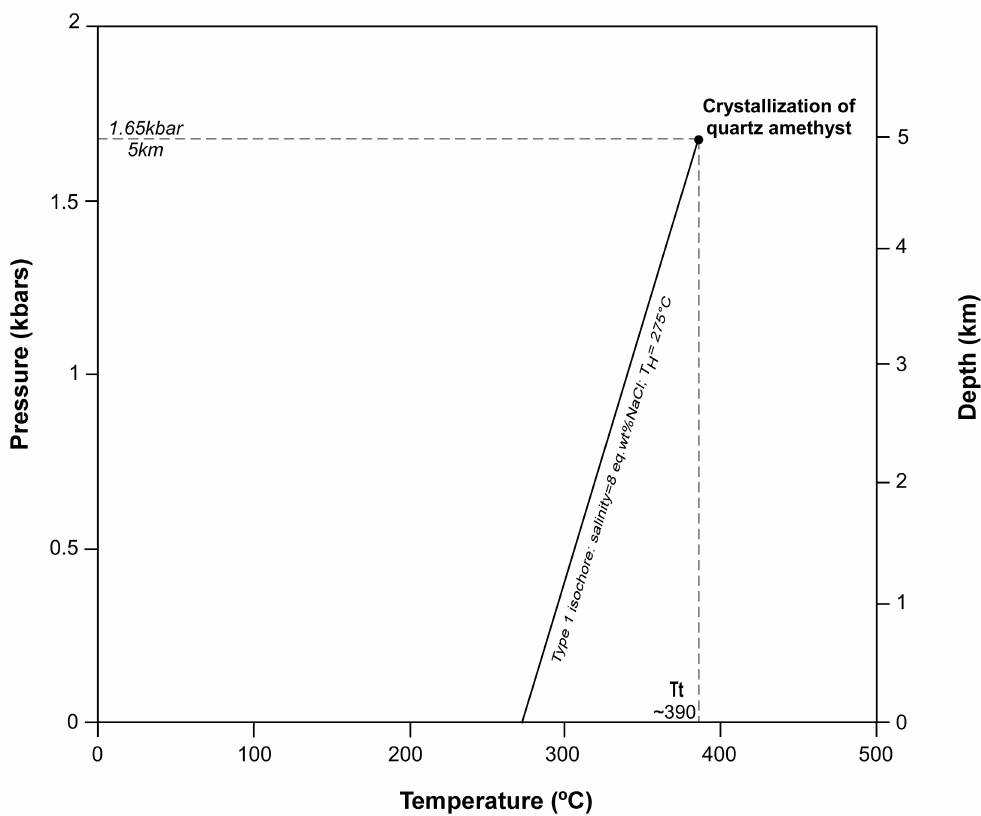
Figure 8. A pressure–temperature model for the formation of the quartz-amethyst vugs using microthermometric data from the primary Type 1 aqueous inclusions. The intersection of the isochore for the primary Type 1 fluid with the estimated maximum pressure for granite emplacement (i.e., ~1.65 kbar) indicates a true trapping temperature (T t ) indicating a crystallization temperature of ~390 °C.